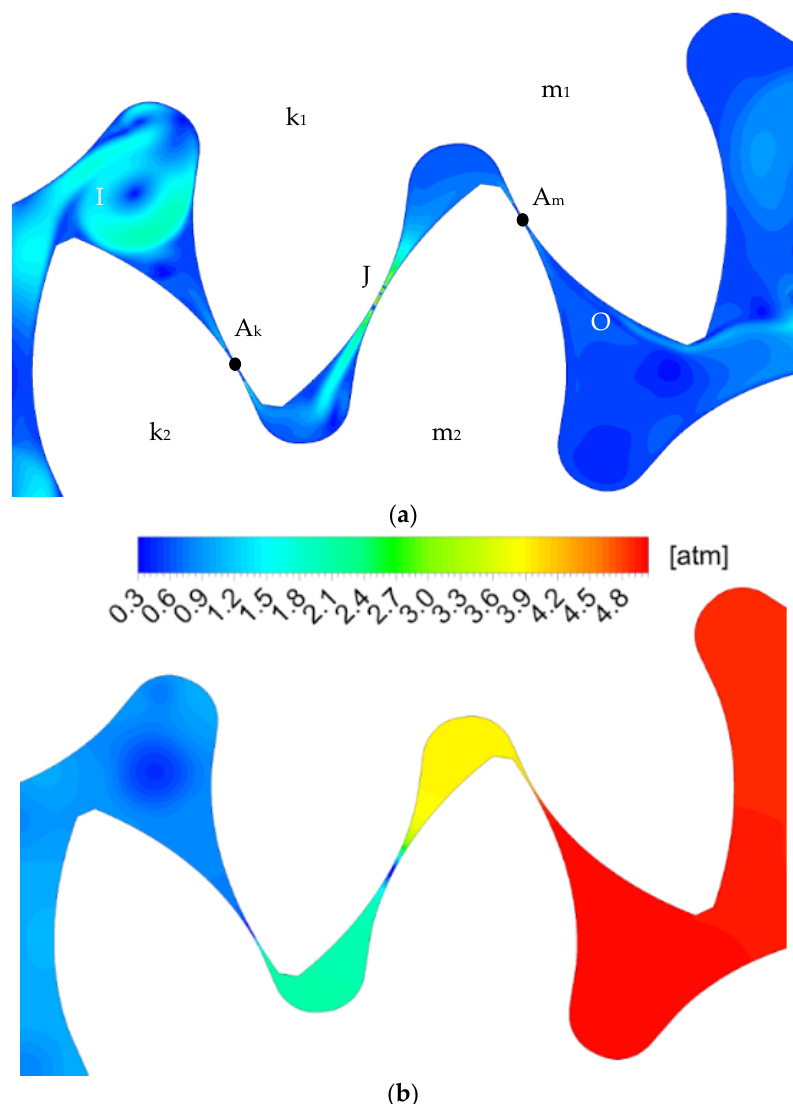
Figure 6. Position b: experimental result [18] picture 3.9; ( a ) velocity field (CFD); ( b ) pressure field (CFD).